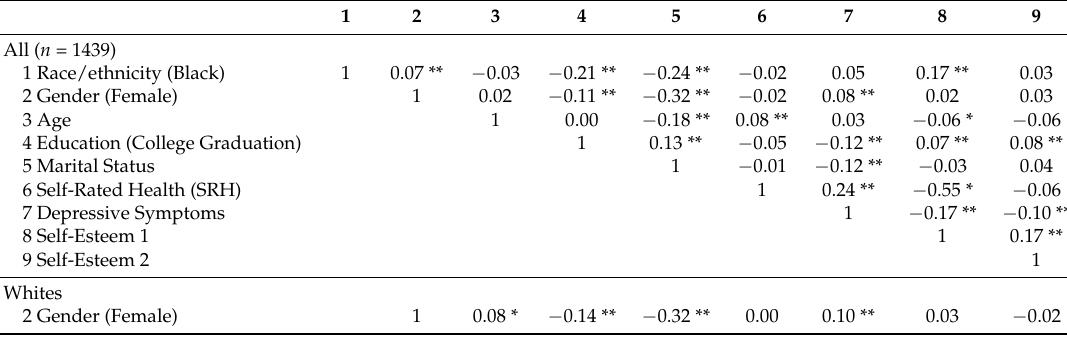
Table 2. Bivariate correlations between baseline and subsequent variables in the pooled sample and by